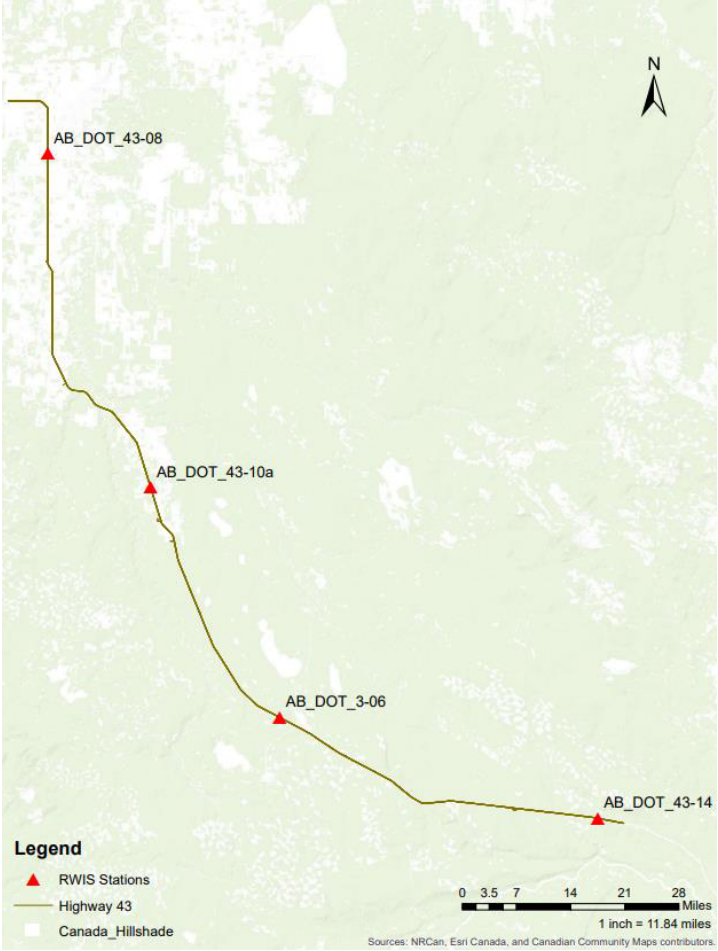
Figure 1. Study area — a segment of Alberta Provincial Highway 43.